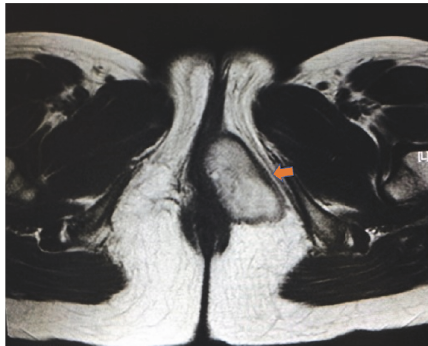
Figure 1: Magnetic resonance imaging of the pelvis showed a well-circumscribed mass in the vulvar subcutaneous region.